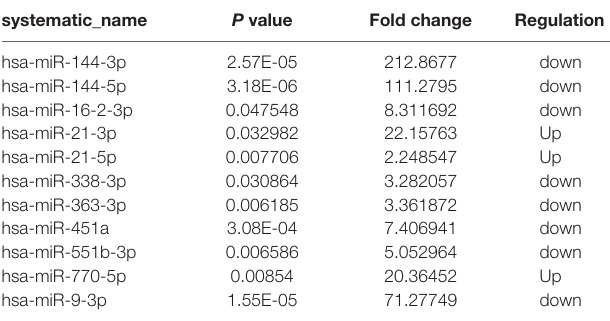
TABlE 1 | miRNA microarray in samples of DCM patients and healthy